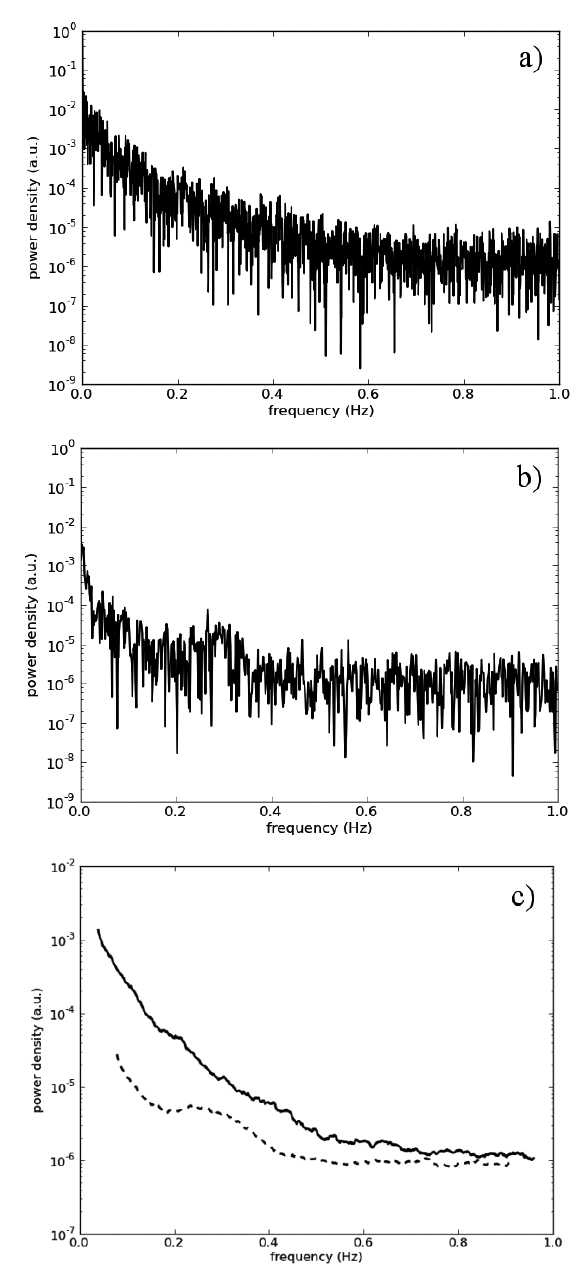
Figure 7. FFT spectral analysis (log of power density vs. frequency) of the (a) Rayleigh and (b) Nakagami-Rice behavior shown in Fig- ures 4 and 5 respectively. (c) FFT Comparison between the Rayleigh (continuous curve) and Nakagami-Rice (dashed curve) behavior ob- tained by doing a 100-values running mean of the values plotted re- spectively in (a) and